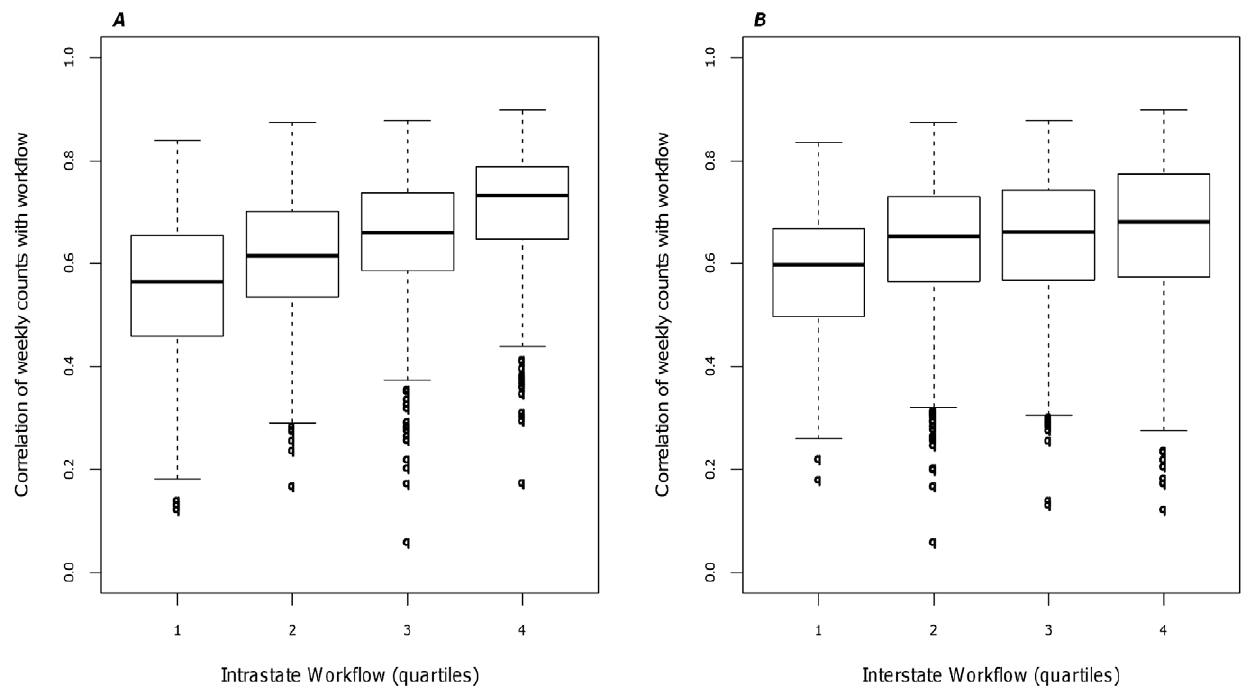
Figure 4. Correlation of weekly time series with human movement. A) Synchrony as a function of workflows. B) Synchrony as a function of Pennsylvania and neighboring county workflows. The distribution of workflow was categorized by quartile. The boxplot within each quartile represent the distribution of the correlation of workflow between pairs of counties.